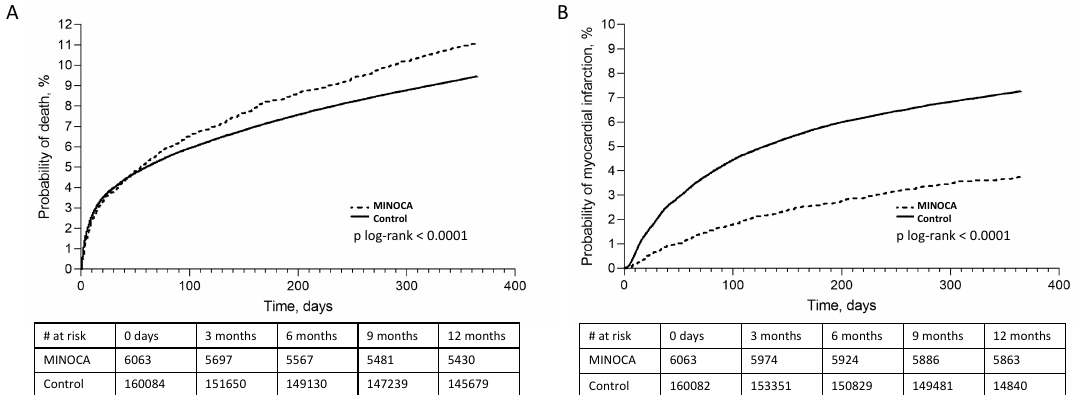
Figure 2. The 1-year Kaplan–Meier events rates. Kaplan–Meier curves show the cumulative incidence rates of ( A ) death and ( B ) myocardial infarction.